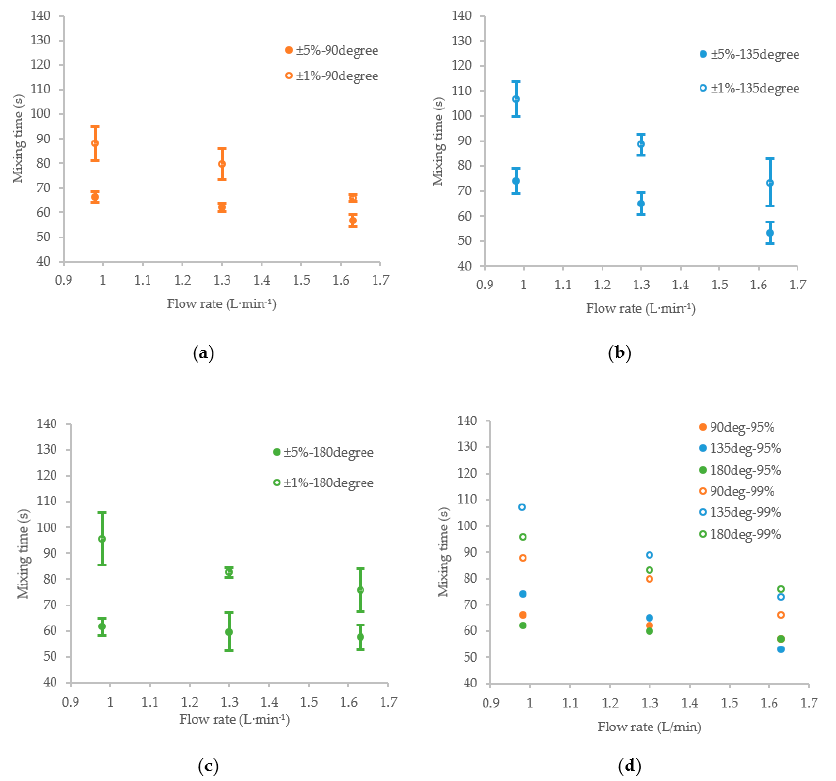
Figure 7. Measured mixing times at different flow rates with various radial-plug angles: ( a ) 90°; ( b ) 135°; ( c ) 180°; and ( d ) total.